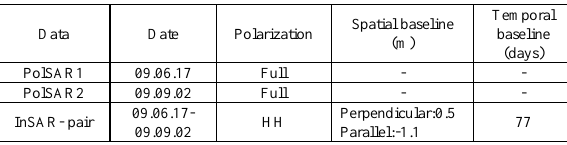
Table 1. The main technical specifications for PolSAR and InSAR